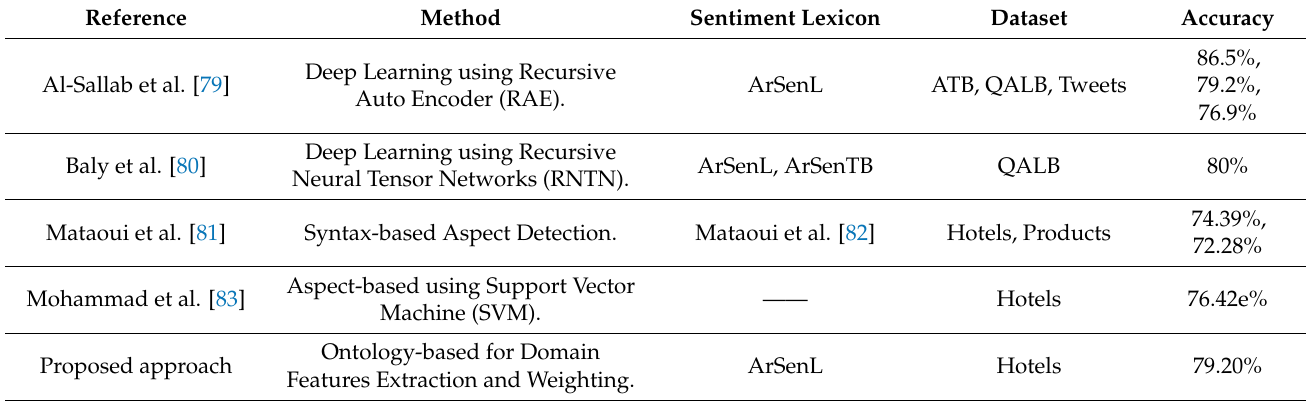
Table 19. A comparison with some state-of-the-art approaches for